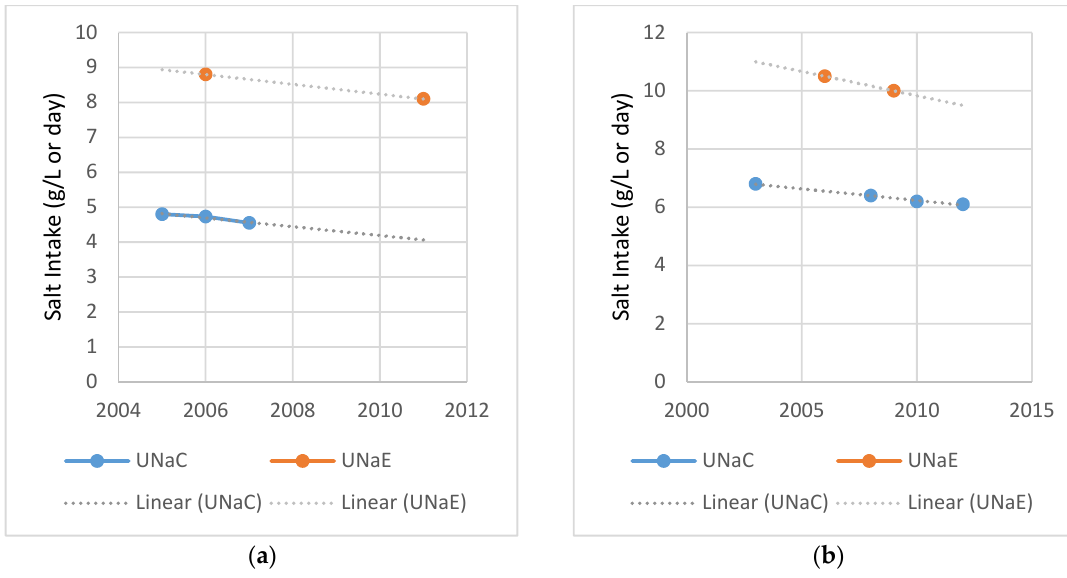
Figure 1. Comparison of National Salt Intake Trends Using 24 ‐ h Sodium Excretion and Urinary Spot Tests ( a ) England national salt intake estimates from UNaE and unadjusted UNaC, Millett 2012 and 2011 National Diet and Nutrition Survey ( b ) Scotland national salt intake estimates from UNaE and unadjusted UNaC, 2013 Scottish Health Survey and 2011 NDNS.